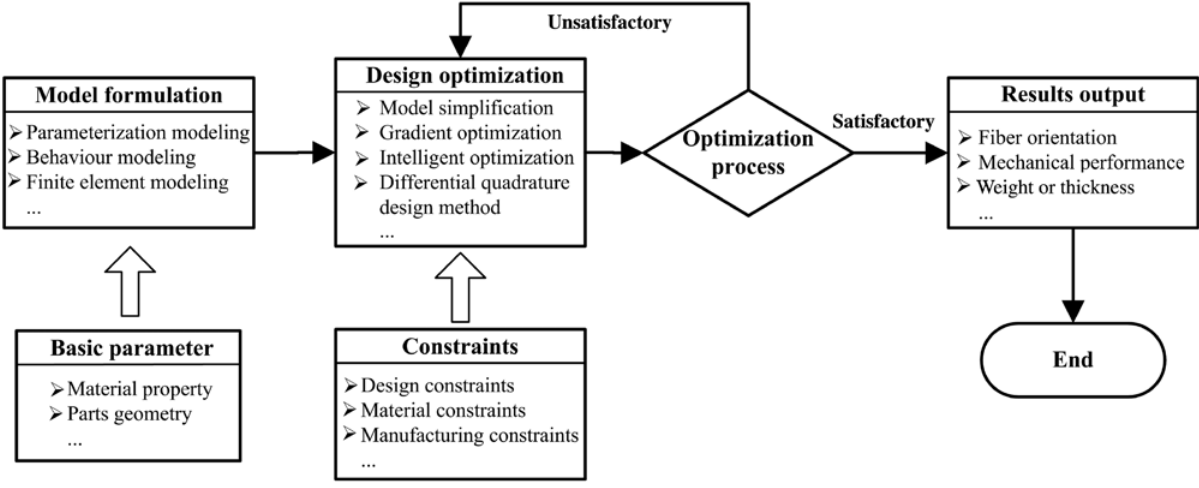
Figure 3: Process of variable stiffness optimization